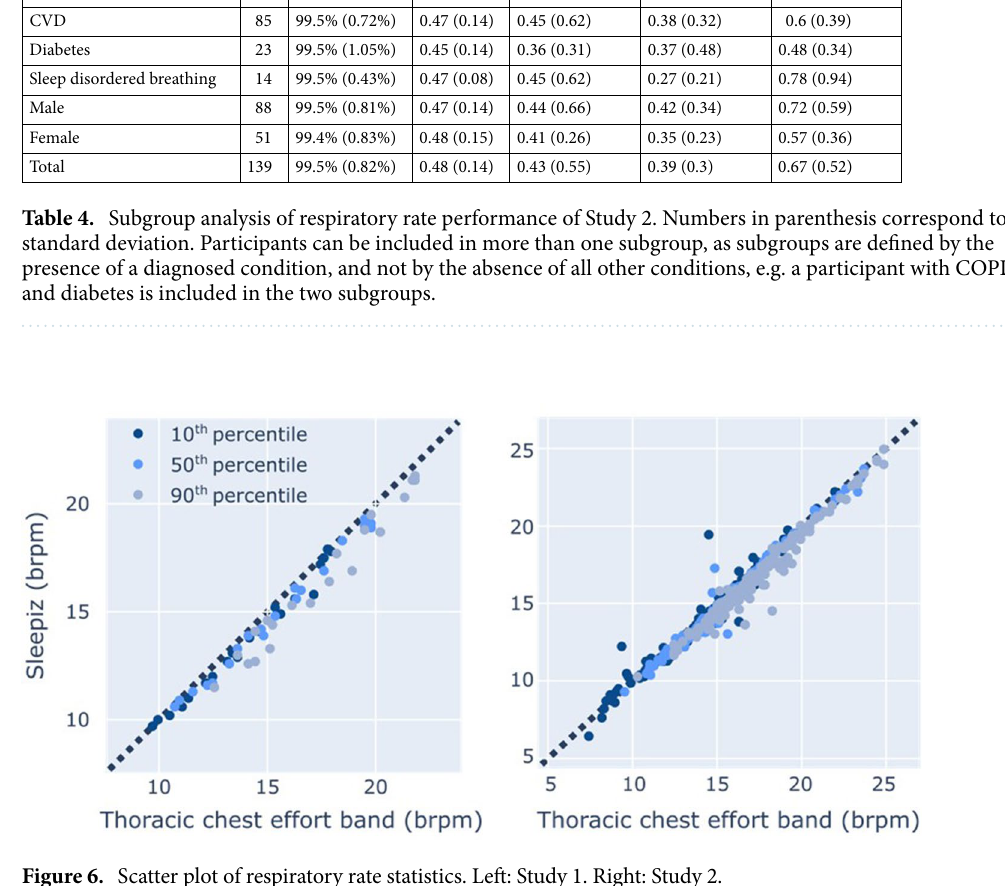
Figure 6. Scatter plot of respiratory rate statistics. Left: Study 1. Right: Study